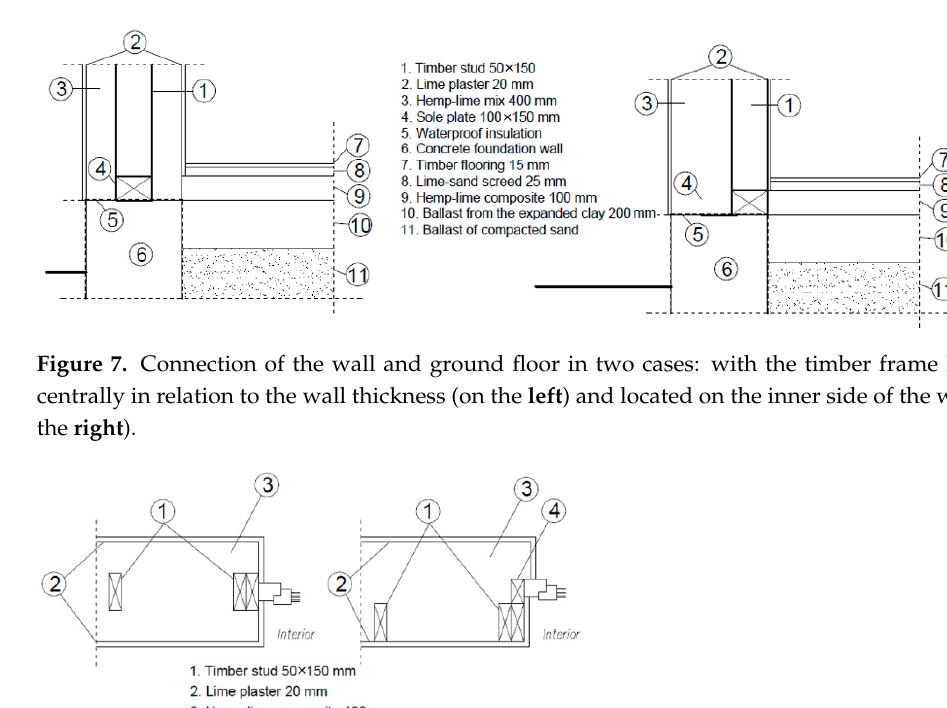
Table 2. Thermal properties of main materials and elements.